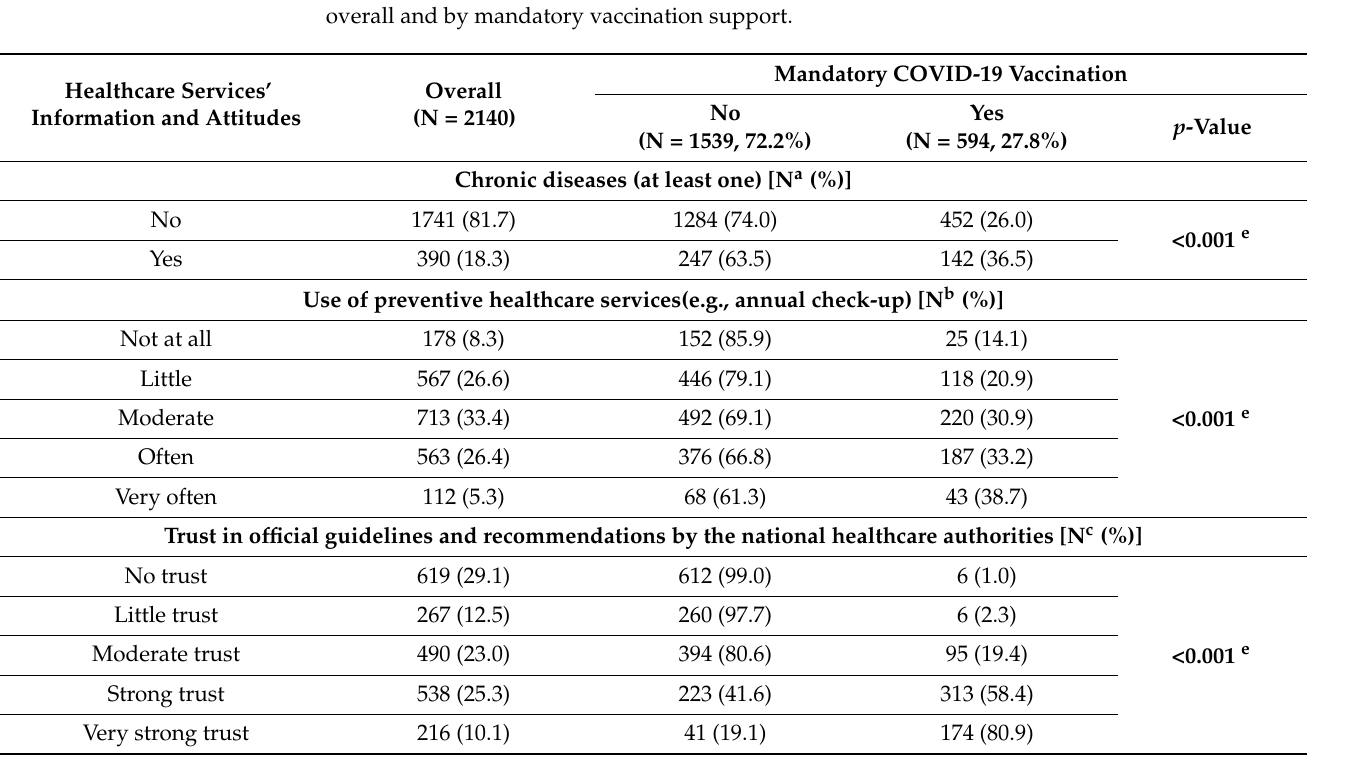
Table 2. Information about participants’ health status and attitudes towards healthcare services, overall and by mandatory vaccination